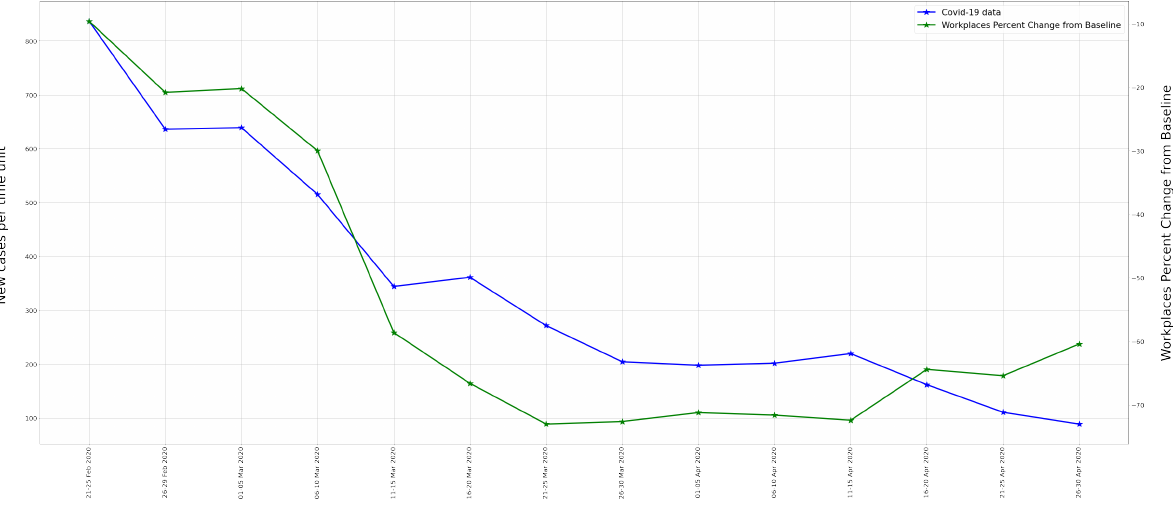
Figure 21. Workplaces vs. daily new cases in